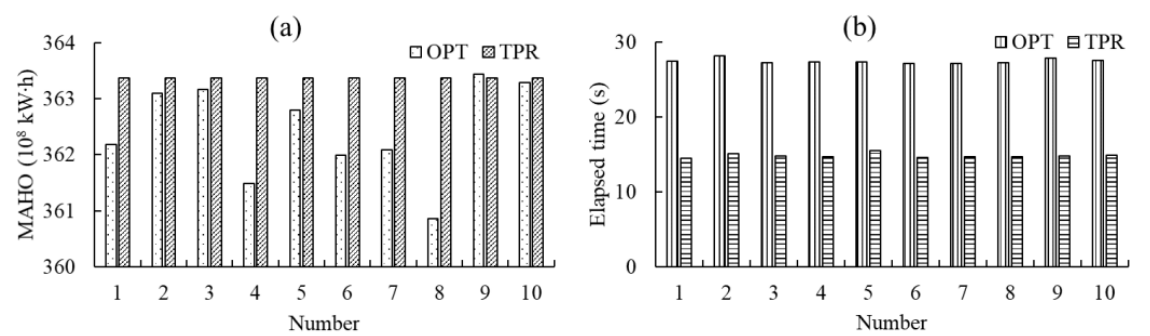
Figure 5. MAHO ( a ) and elapsed time ( b ) results based on the OPT approach and the TPR rules (Note: all calculations were realized in the MATLAB environment on the same computer).